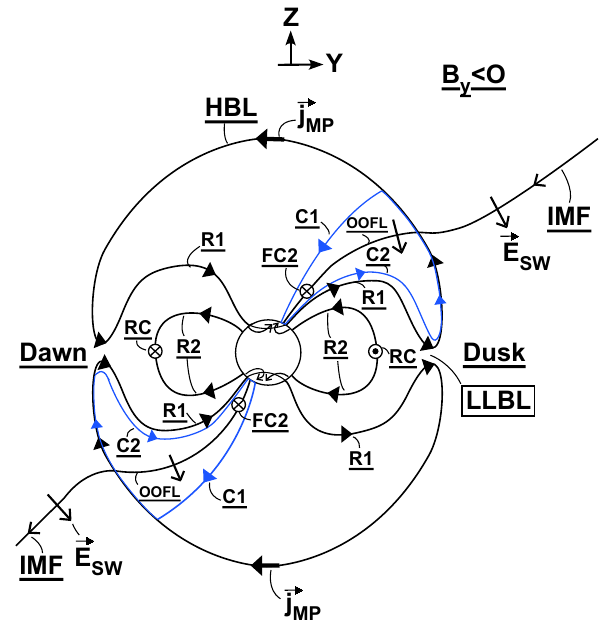
Fig. 11. Schematic IMF-magnetosphere-ionosphere interconnec- tion topology in stage two of the open field line evolution for south- west-directed IMF ( B z < 0; B y < 0) conditions. The emphasis here is on old open field lines (OOFLs), sheets of field-aligned electric currents (C1-C2-R1-R2) and flow channel FC 2. Current circuit in- volving Birkeland currents C1-C2 are marked in blue. The figure shows the GSM Y-Z plane along the dawn-dusk meridian (X = 0). Dusk is to the right. North is